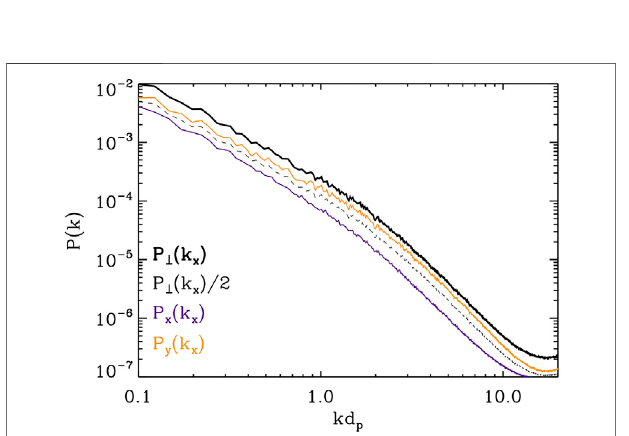
FIGURE 3 | Reduced spectra of the fl uctuations of the magnetic fi eld components B y and B x de fi ned with respect to a fi xed sampling direction k x for a simulation with β p (cid:2) 0 . 5. The thick solid black line corresponds to the total perpendicular power P ⊥ ( k x ) ; the dashed line shows P ⊥ ( k x ) / 2, also corresponding to the average power in any perpendicular magnetic fi eld component in the axisymmetric